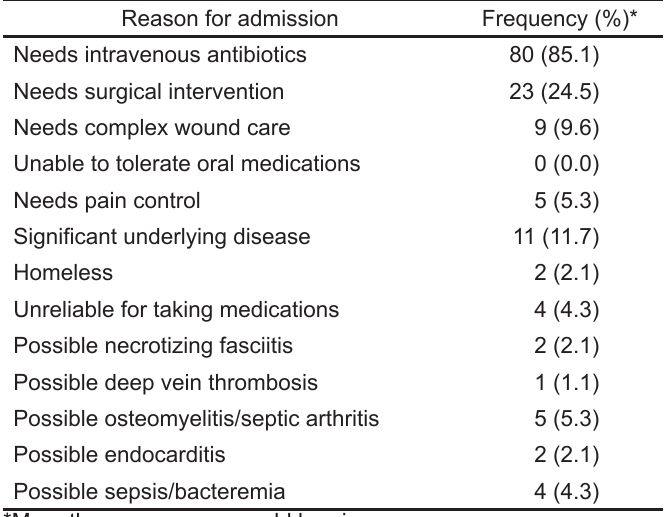
*More than one reason could be